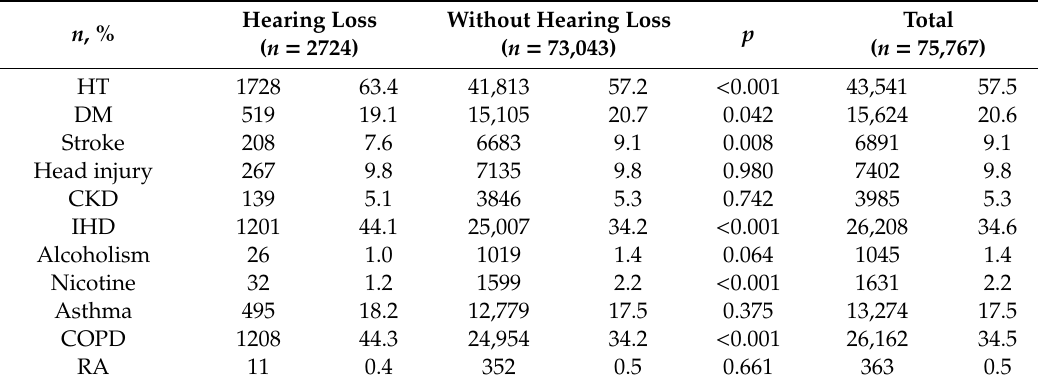
Table 2. Distribution of the comorbidities of the study